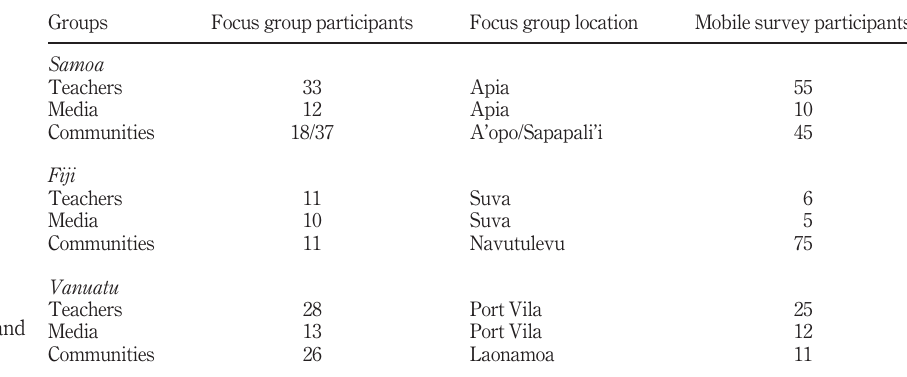
Table I. Participants by method, country and